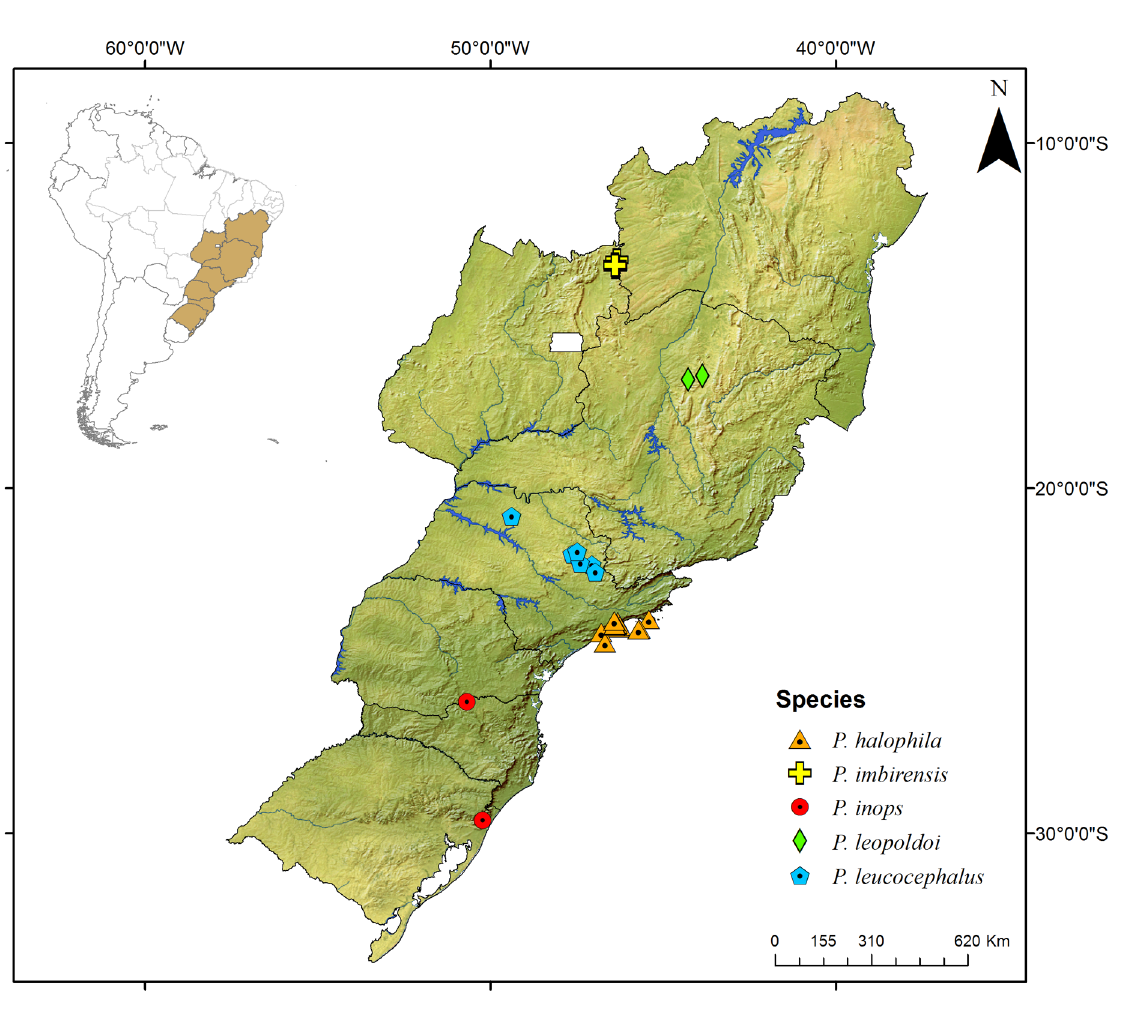
Fig. 183. Distribution map of the species Pseudonannolene halophila Schubart, 1949, P.